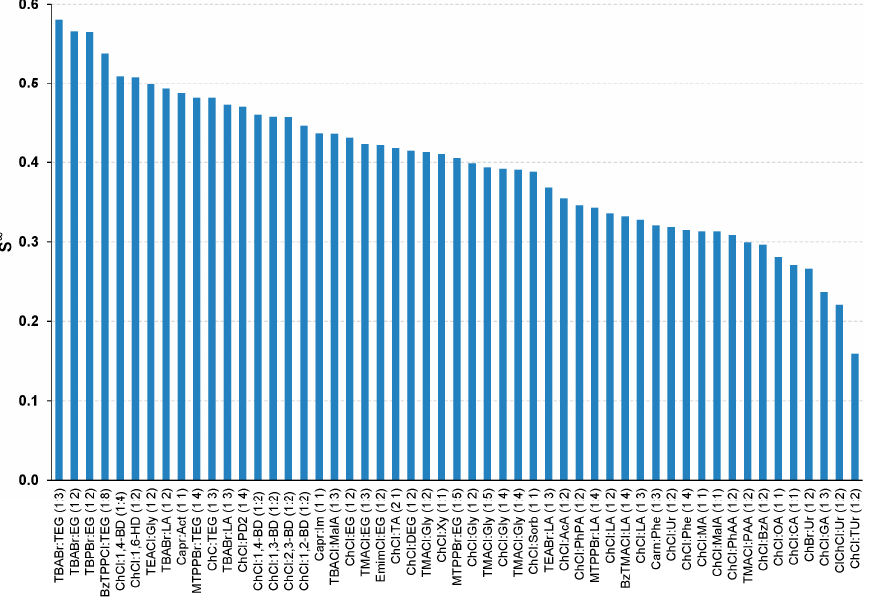
Figure 2. Selectivity of the selected DESs at infinite dilution. Table 2. The top 10 DESs according to COSMO-RS screening by C ∞ , S ∞ and PI ∞ for the separation of 1-hexene and